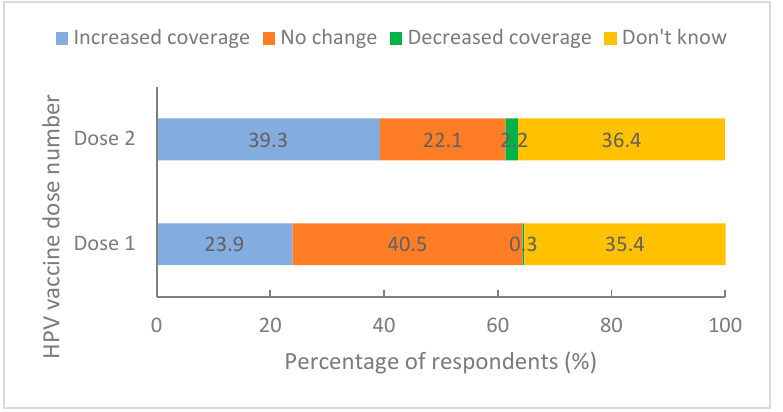
Figure 1. Survey respondent perceptions of the influence of the change to a 2-dose schedule on HPV vaccination coverage for adolescents aged <15 years in their area ( n = 1128).